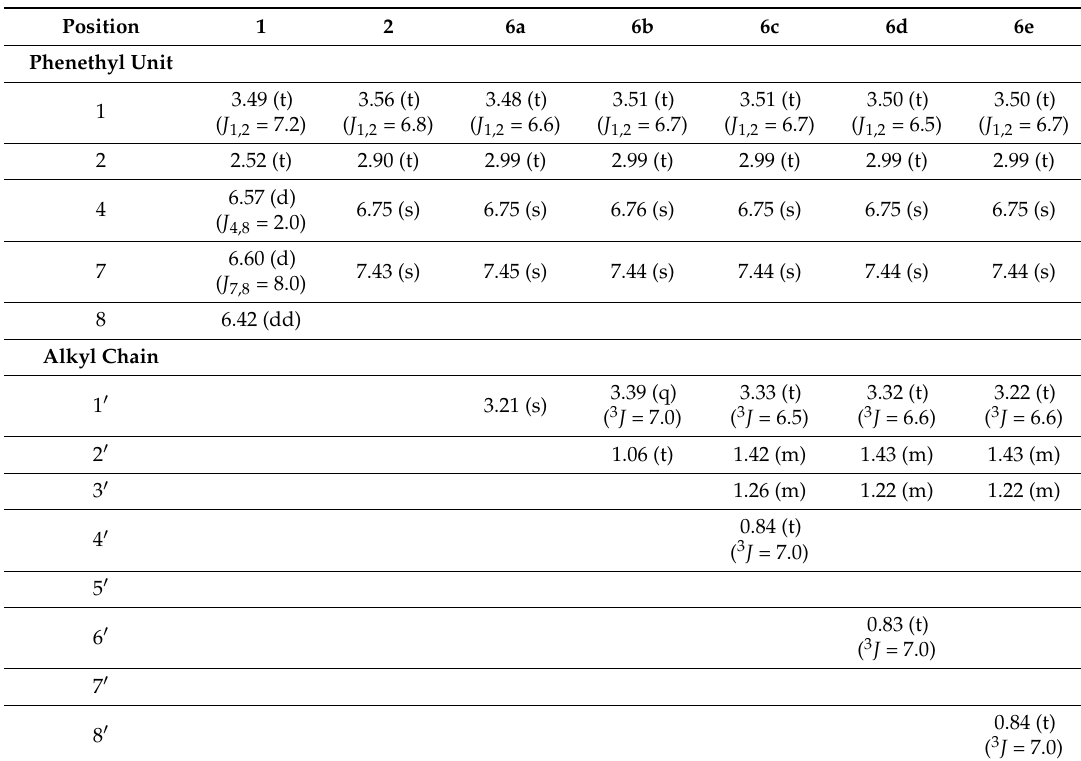
Table 1. 1 H-NMR Data (500.13 MHz, hexadeuterated dimethyl sulfoxide DMSO- d 6 , 303 K) for compounds 1 , 2 and 6a – e a